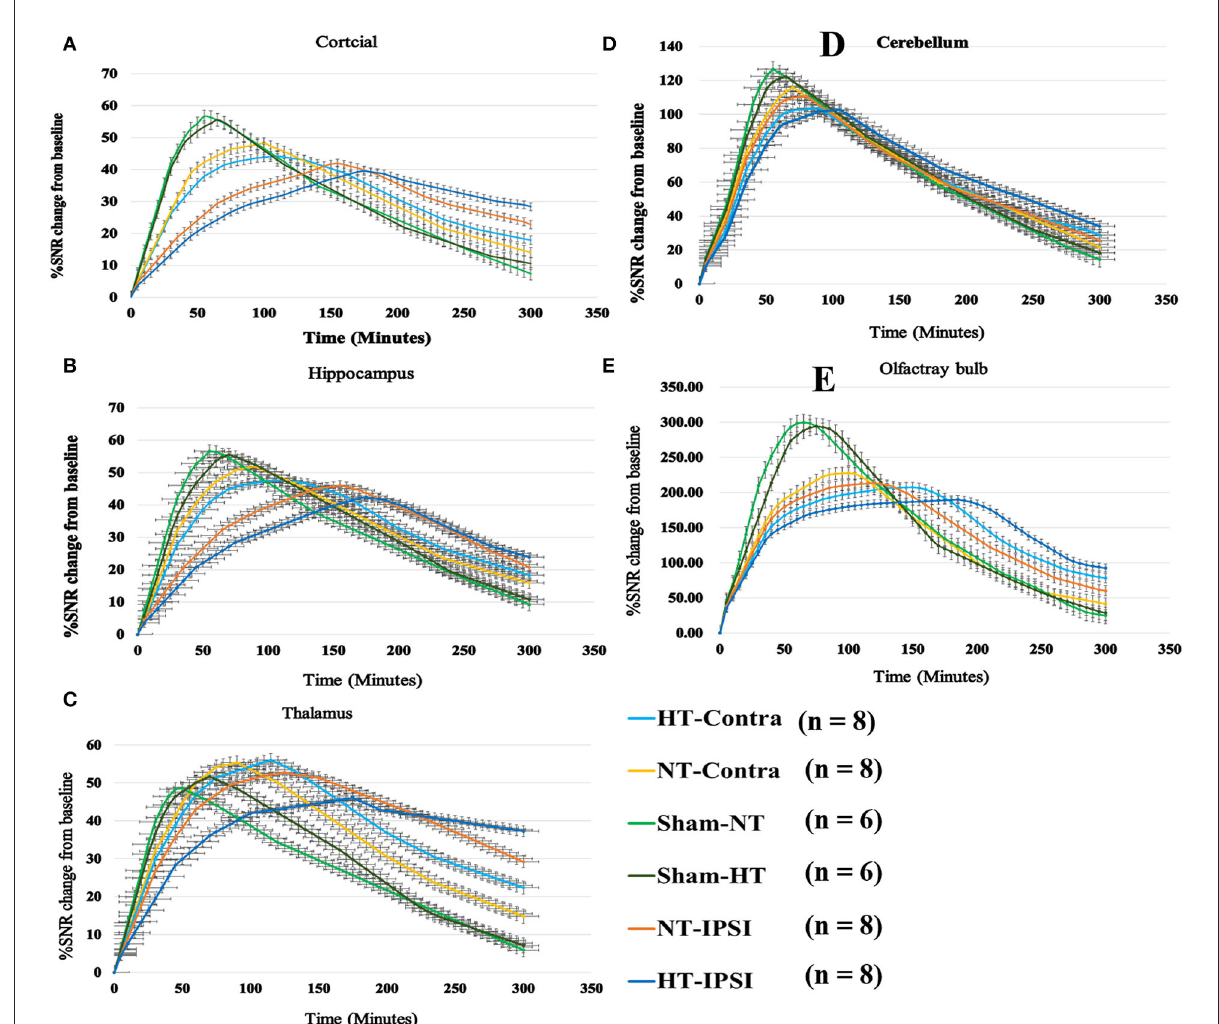
FIGURE8 Group average TICs derived from dynamic time series of T1WI with Gd-DTPA. The SNR% changes from baseline along time obtained from coronal T1WI sections encompassing bilateral brain subregion including ipsilateral and contralateral cortex (A) , ipsilateral and contralateral hippocampus (B) , ipsilateral and contralateral thalamus (C) , ipsilateral and contralateral cerebellum (D) , and ipsilateral and contralateral olfactory bulb (E) . Within the major experimental period, longer to peak enhancement, lower SNR% value, and more residual contrast at the end of the experiment are visualized in all brain subregions in the TBI-HT group, compared TBI-NT group, and in TBI-NT group, compared to both Sham-NT and Sham-HT groups. Similar TIC appearance also shows in all ipsilateral subregions (A , B , C , E) except cerebellum (D) in both TBI-HT and TBI-NT brain, compared to the contralateral subregions, but not in sham injury brains. HT-contra, contralateral subregion of TBI-HT rat brain; HT-IPSI, ipsilateral subregion of TBI-HT rat brain; NT-contra, contralateral subregion of TBI-NT rat brain; NT-IPSI, ipsilateral subregion of TBI-NT rat